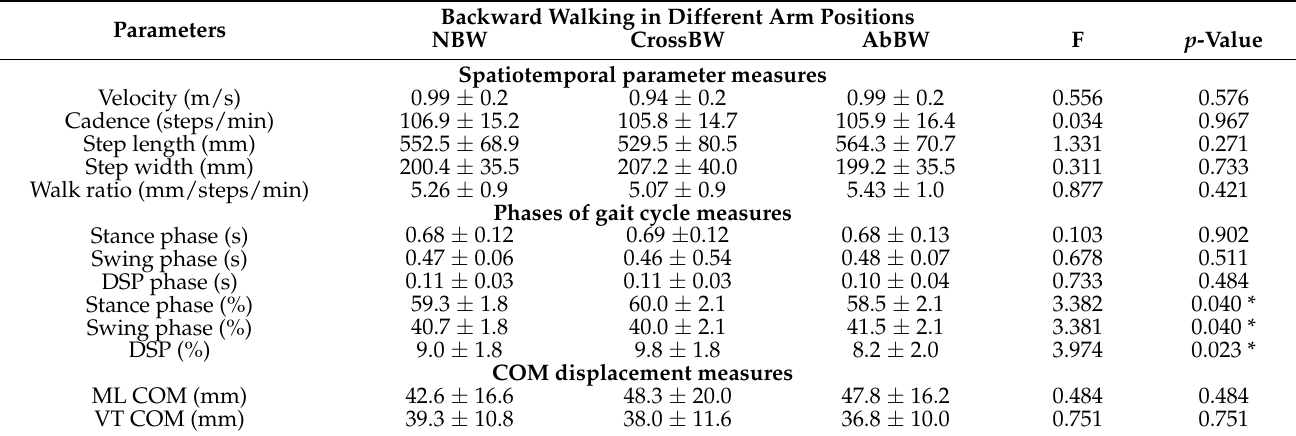
Table 3. Effects of arm position on backward